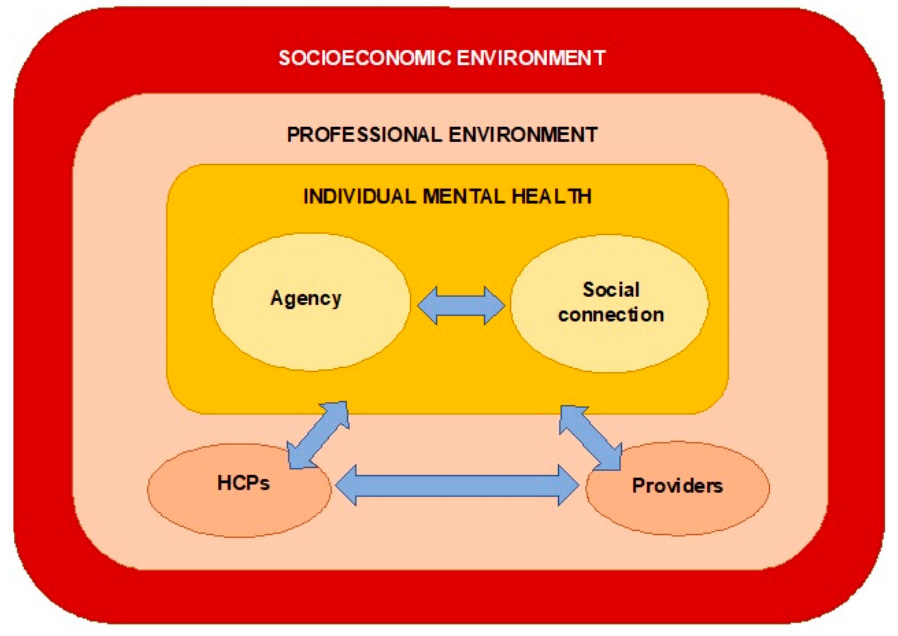
Figure 2. Interactions between themes.